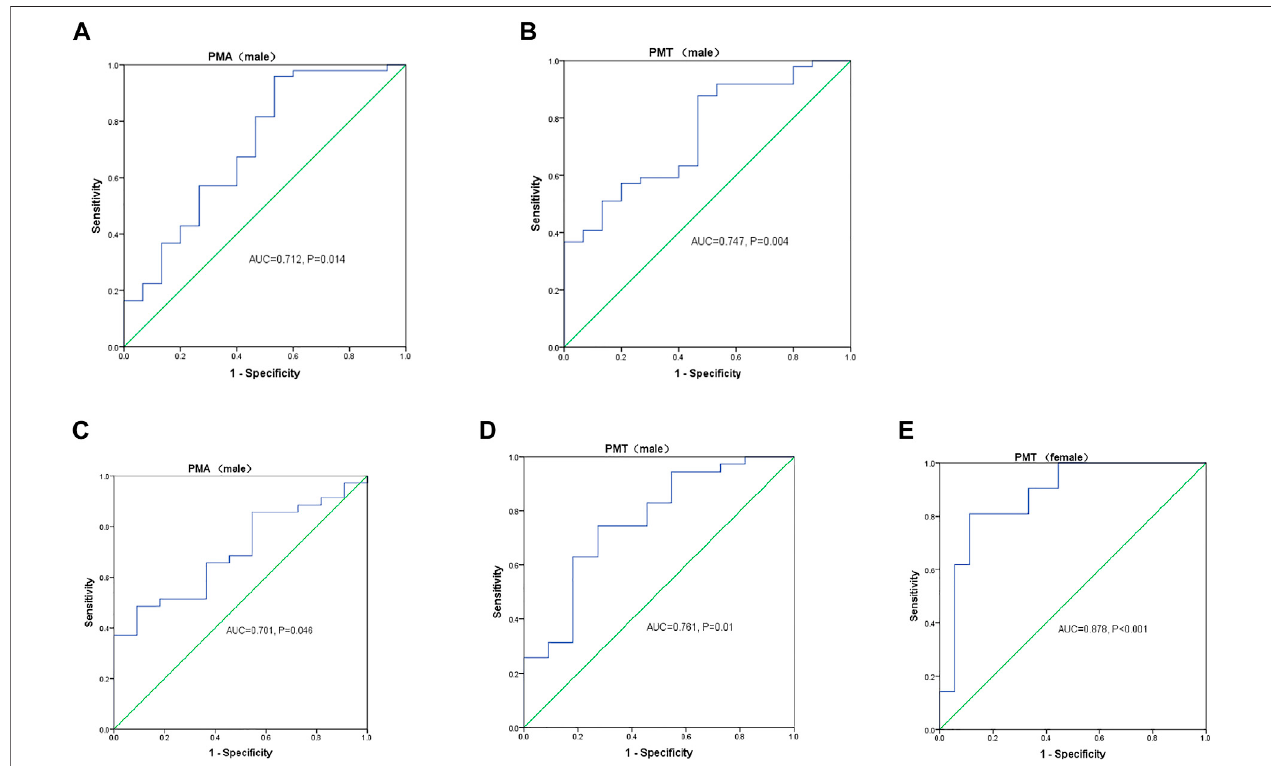
FIGURE 4 | Sex-strati fi ed receiver operating characteristic (ROC) curve analyses of the pectoralis muscle cross-sectional area (PMA) and pectoralis muscle attenuation (PMT) measurements for predicting (A,B) 6-min walk distance (6MWD) < 350 m in patients with stable chronic obstructive lung disease (COPD) and (C – E) respiratory failure in patients with acute exacerbation of COPD. AUC, area under the curve.